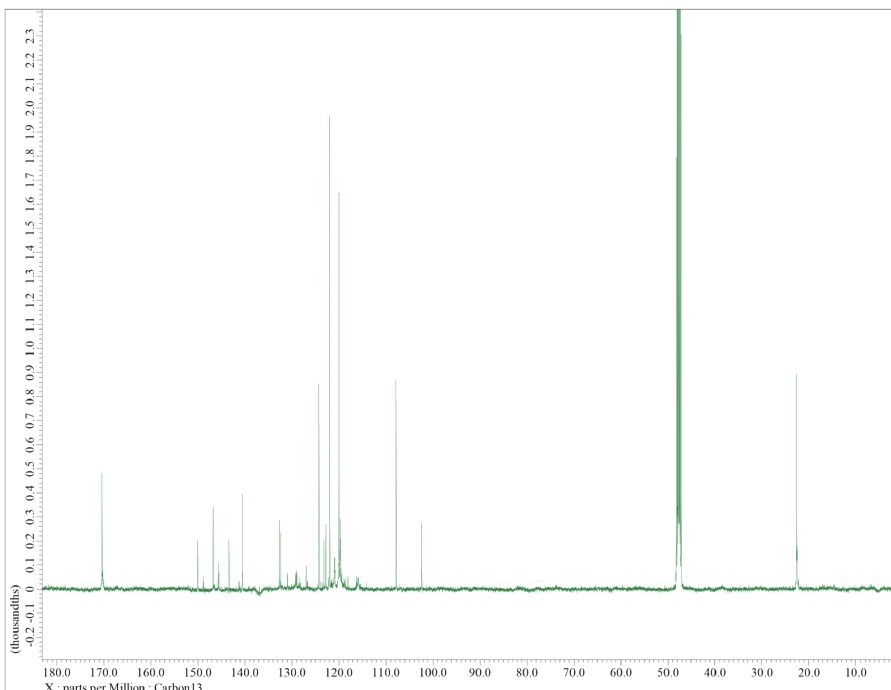
Figure 5: 1 H-NMR spectrum of 4-APAP.